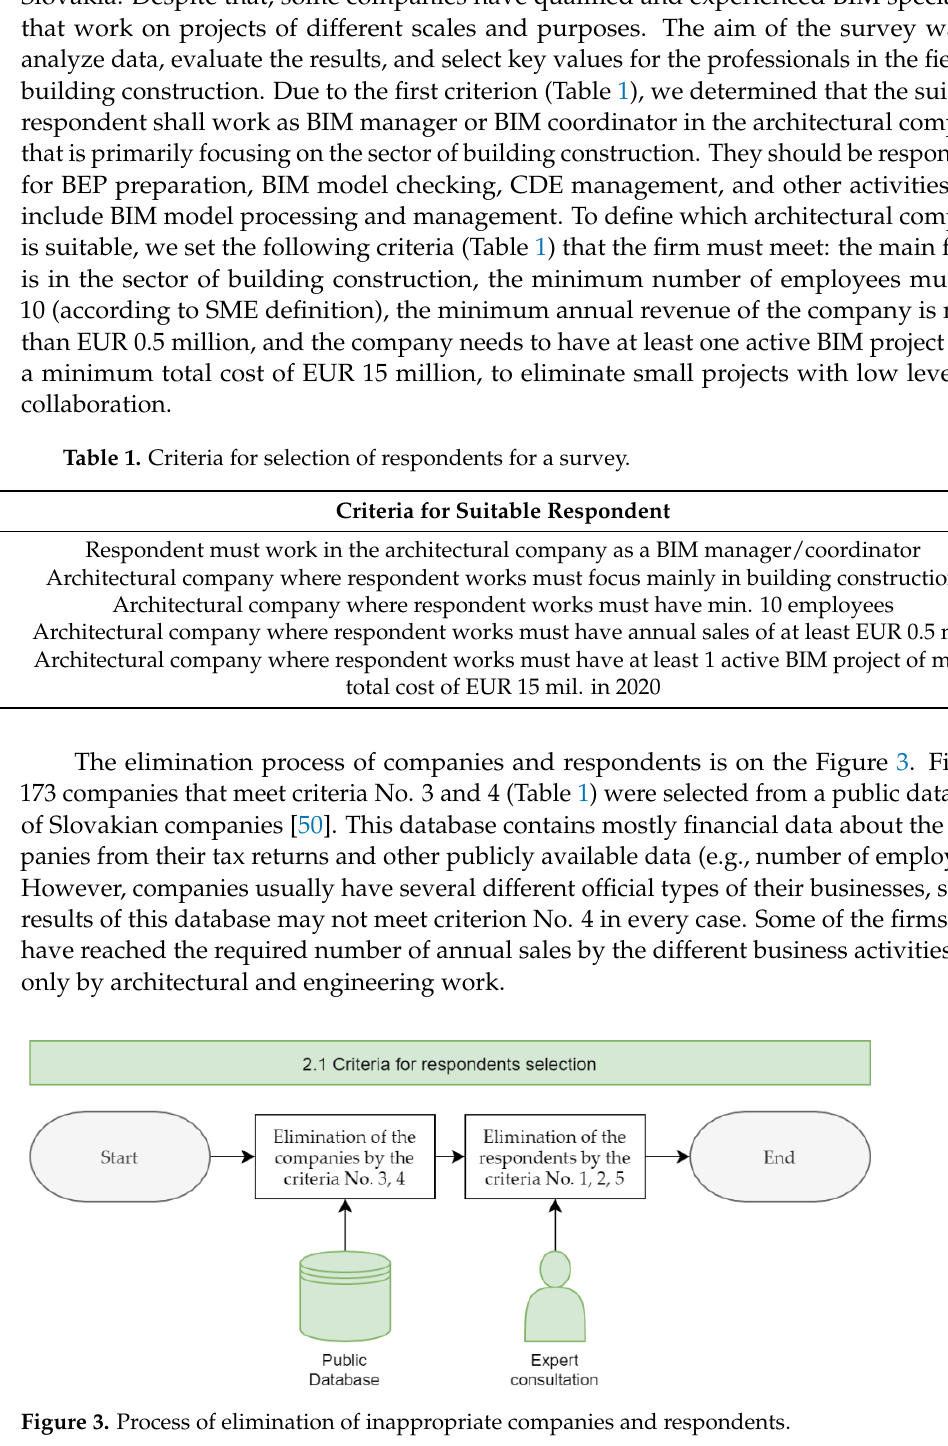
Figure 2. Process map of the research methodology.